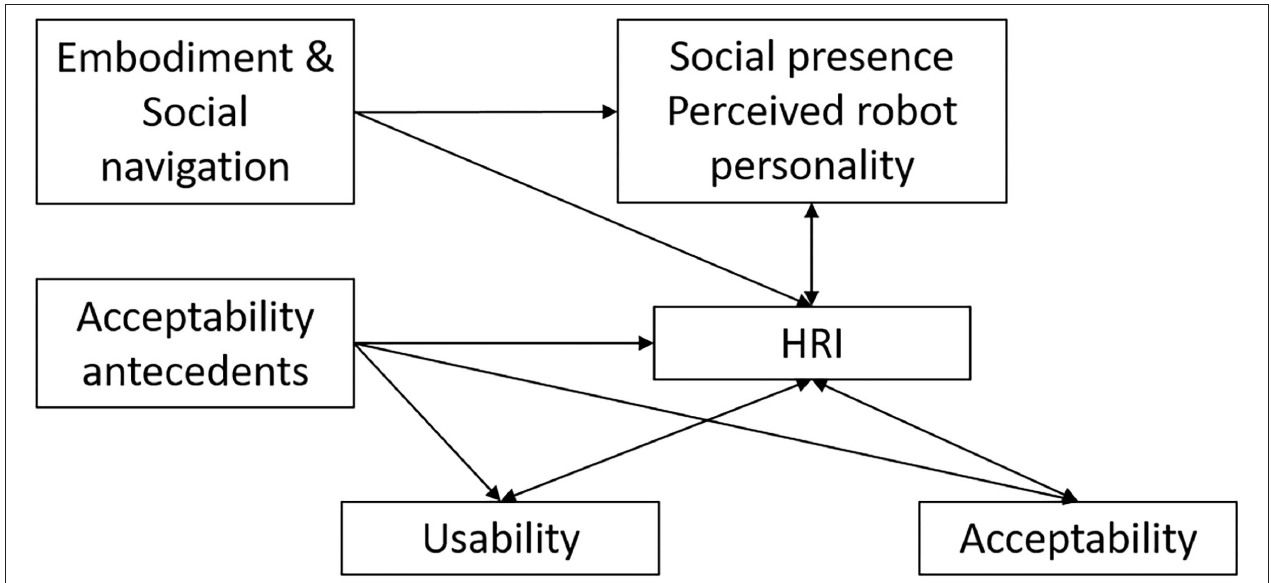
FIGURE 1 | The Robot-Era theoretical model that summarized the direct influences within the different factors. that explain the level of technology acceptance by older